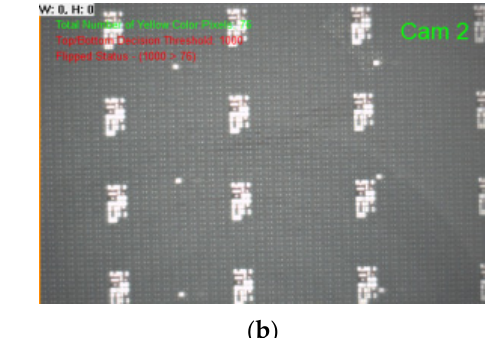
Figure 9. Detection of wafer inversion, ( a ) mask color pattern of the front side; ( b ) mask color pattern of the back side.